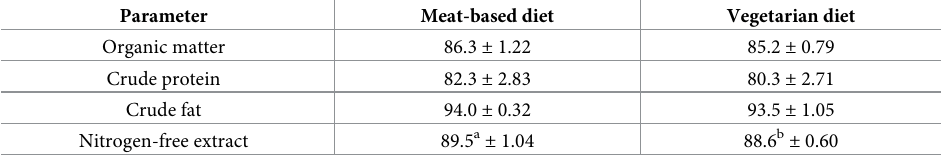
Table 3. Apparent nutrient digestibility (%) of nutrients in dogs fed the meat-based diet and vegetarian diet (mean ±